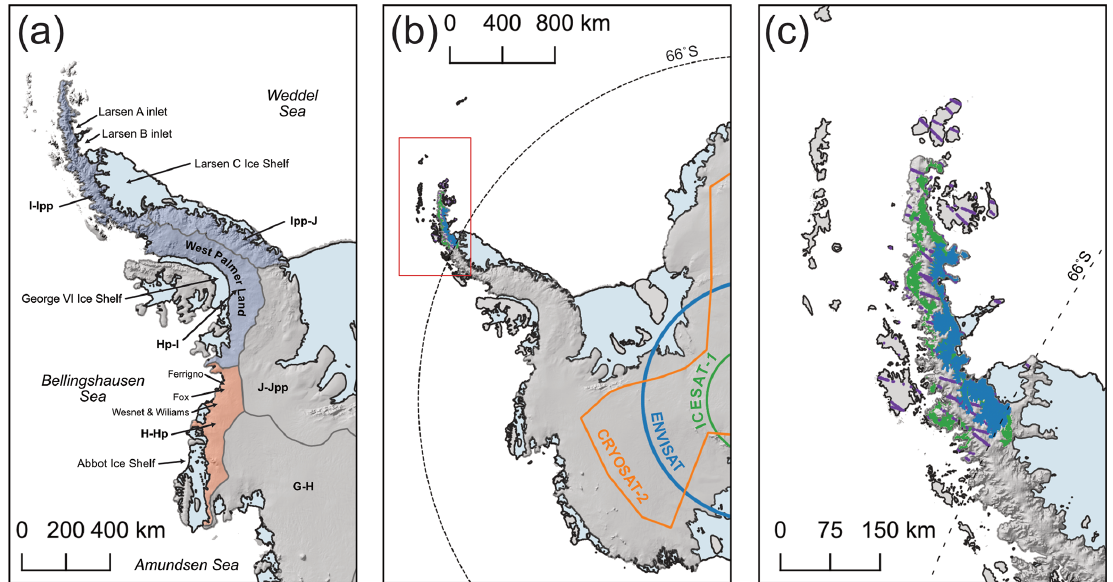
Figure 1. (a) Region of interest for this study, overlain with drainage basin definitions (Rignot et al., 2011b, 2013). Basins included in the Ice Sheet Mass Balance Intercomparison Exercise (IMBIE) (Shepherd et al., 2018) definition of the AP are shaded in purple, with orange basins indicating those outside the AP but included in this study. (b) Spatial coverage of altimetry and DEM datasets for the region. The latitudinal limits of ICESat and ENVISAT are shown in green and blue, respectively. The orange line indicates the CryoSat-2 POCA/swath to low- resolution mode (LRM) transition (with LRM coverage south of the orange delineation). The dashed latitudinal line at 66 ◦ S indicates the separation between ICESat data used over the interior of the ice sheet (Martín-Español et al., 2016) and the optimized data over the northern AP (Scambos et al., 2014). (c) Zoomed spatial coverage of the red bounding box in (b) , indicating the datasets used over the northern AP. Purple and green regions indicate coverage of the optimized ICESat data and dDEM data, respectively, from Scambos et al. (2014). Blue regions indicate coverage of dDEM data from Rott et al. (2018). All data are overlain on the hill shade of the reference elevation model of Antarctica REMA DEM (Howat et al.,